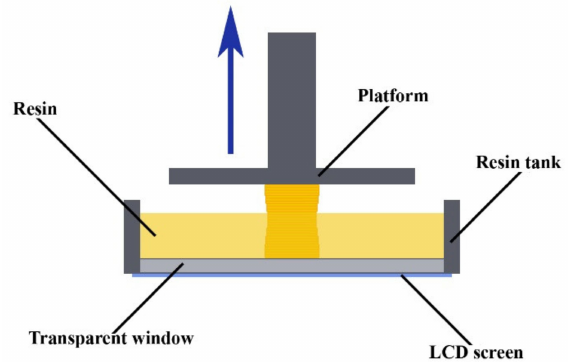
Figure 2. Schematic view of DPP process.